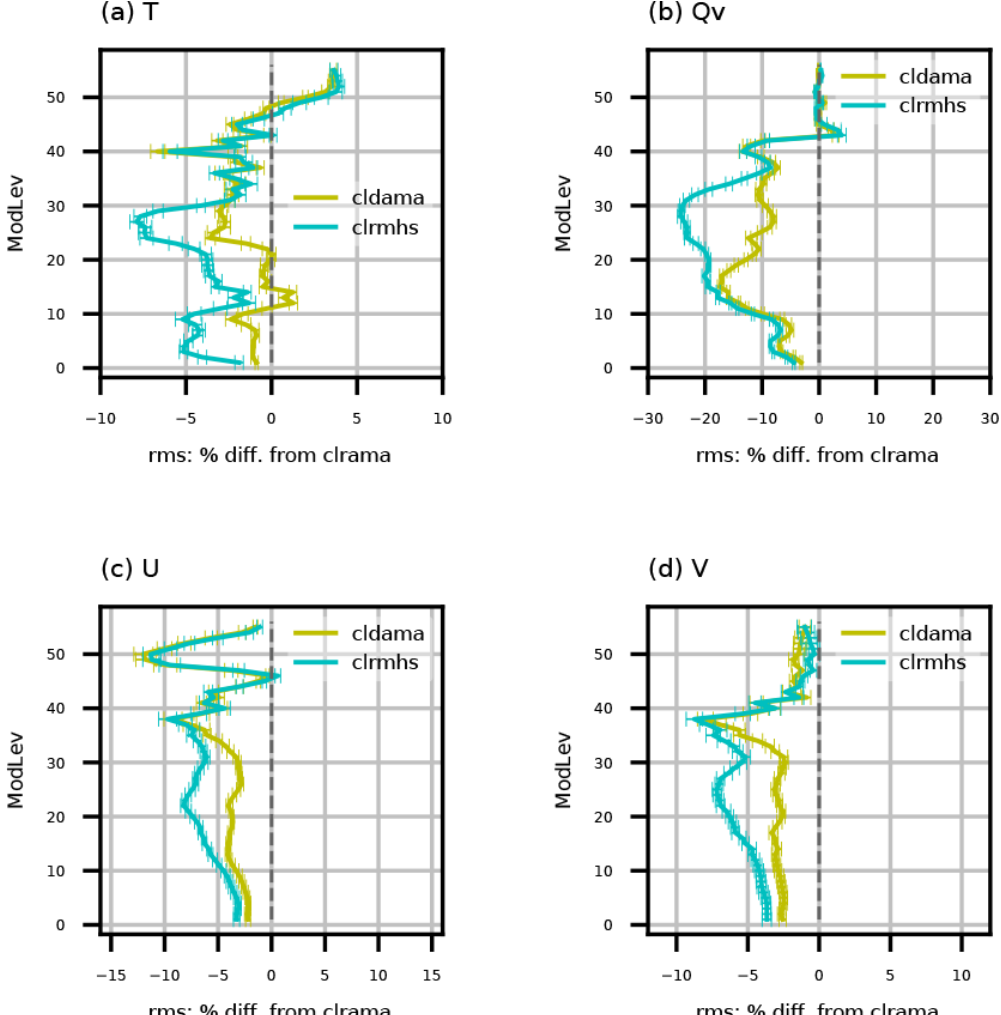
Figure 6. Vertical distributions of relative RMSE reduction (with respect to GFS analyses) of cycling background for global (a) temperature, (b) water vapor mixing ratio, (c) zonal wind, and (d) meridional wind ( cldama and clrmhs versus clrama ). Statistics are for the period from 00:00UTC, 18 April, to 18:00UTC, 14 May